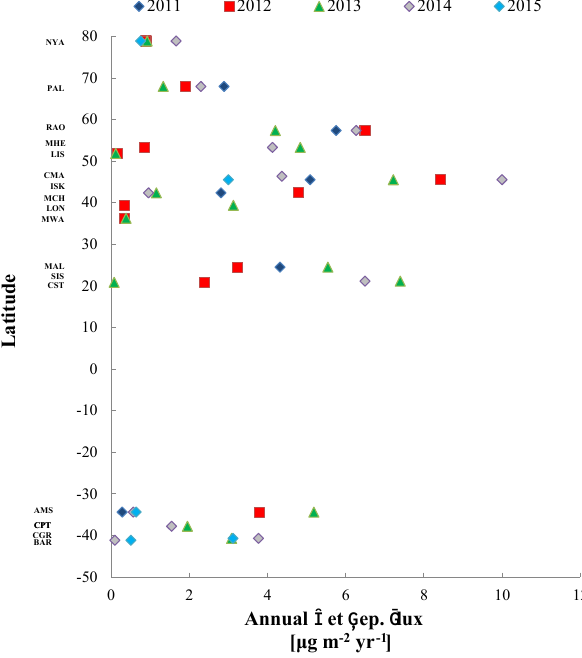
Figure 1. Scatterplot reporting the annual wet deposition fluxes ver- sus latitude observed at the 17 GMOS sites during